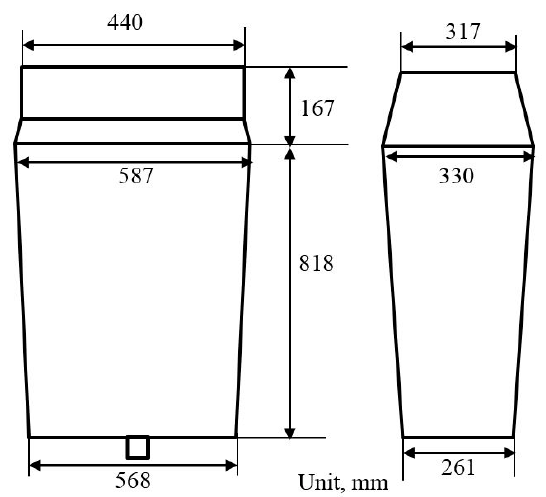
Figure 1. Dimensions of the physical model (unit, mm).